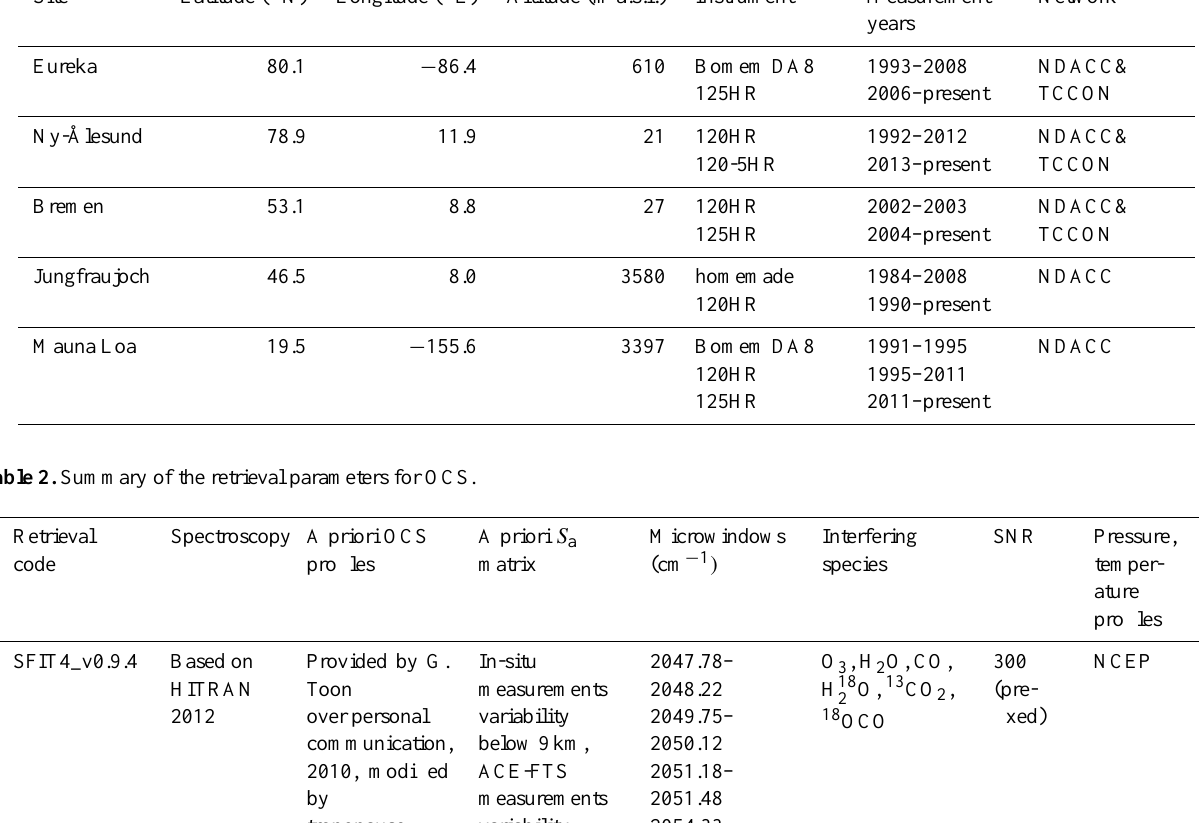
Table 1. FTIR sites used in this study. Site